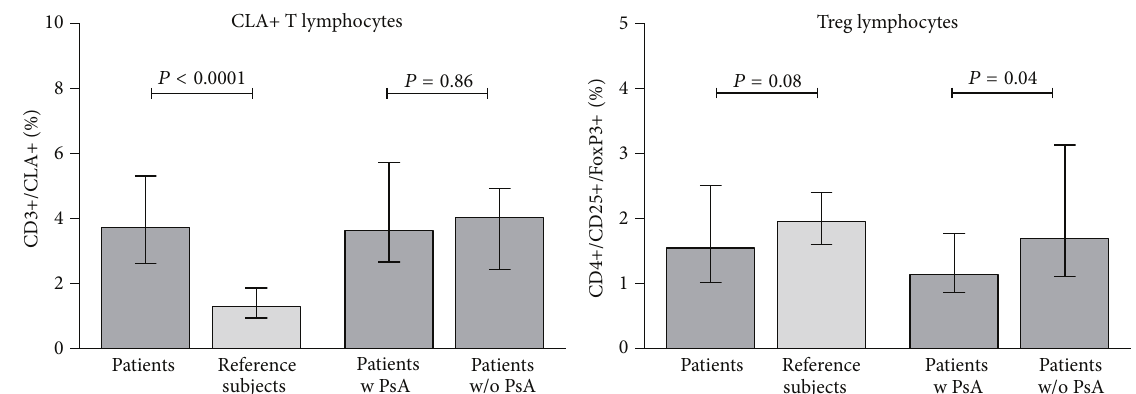
Figure 3: Comparison (unpaired, nonparametric 𝑡 -test) of baseline values of peripheral blood CD3+CLA+ or CD4+/CD25+/FoxP3+ T cells (Treg) in overall patients and a group of healthy subjects or in psoriatic patients with (w) or without (w/o) joint disease. Depicted values are median and interquartile